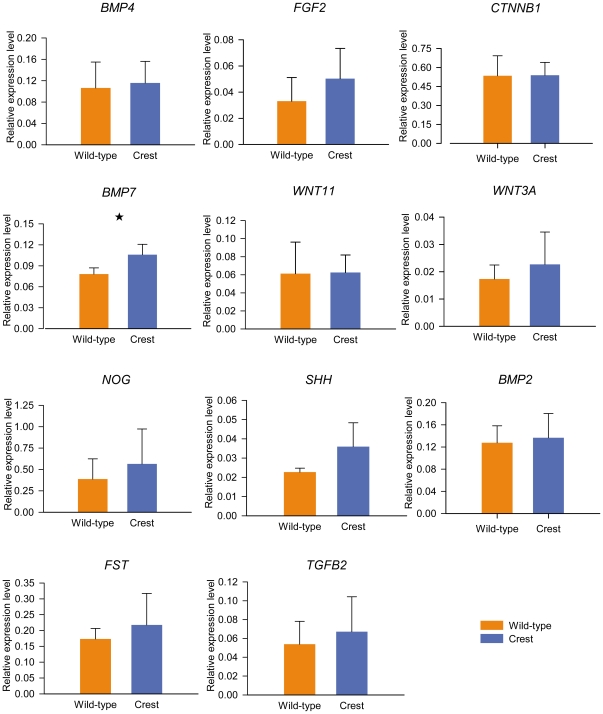
RT-PCR analysis of genes involved in feather development in cranial skin from Crested and wild-type chickens (*, P<0.05).
GAPDH was used as a normalising control. Relative expression levels were obtained by the 2−ΔΔCT method.